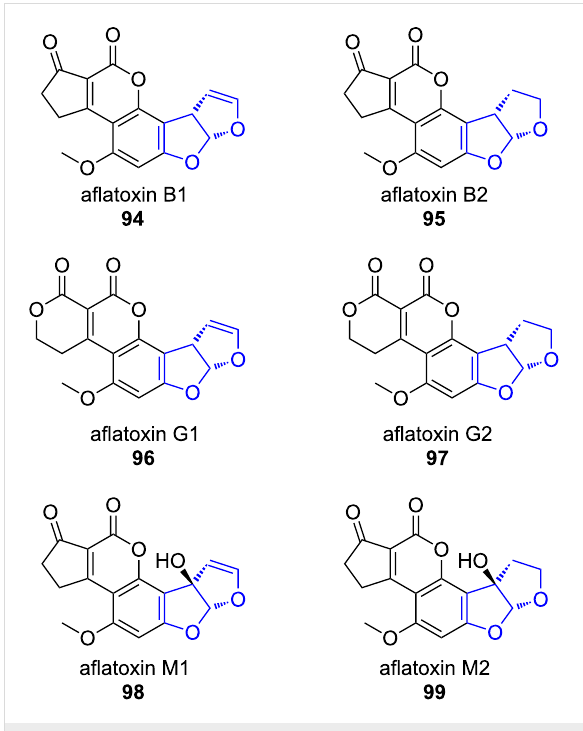
Figure 3: The four major aflatoxins produced by Aspergilli are the types B1, B2, G1 and G2 ( 94 – 97 ). In the digestive tract of animals, aflatoxins B1 and B2 ( 94 and 95 ) are oxidized to M1 and M2 ( 98 and 99 ), respectively [80,81].